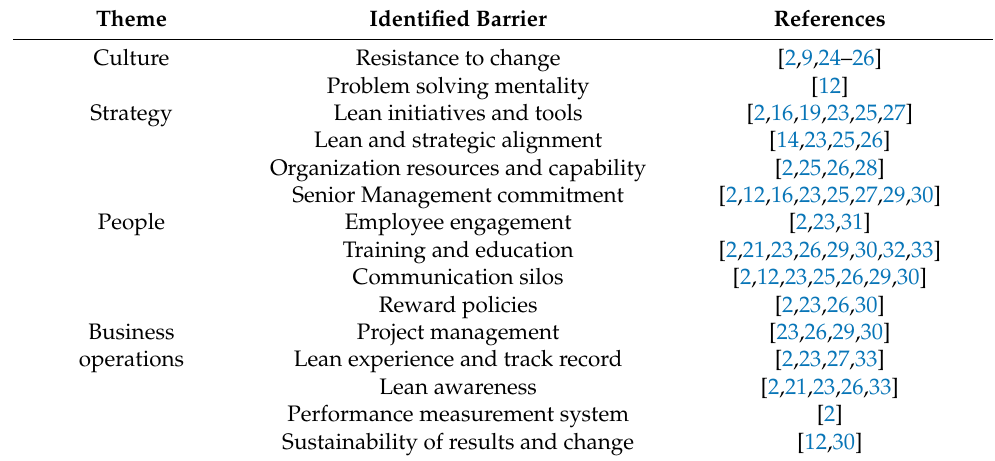
Table 1. Lean Implementation